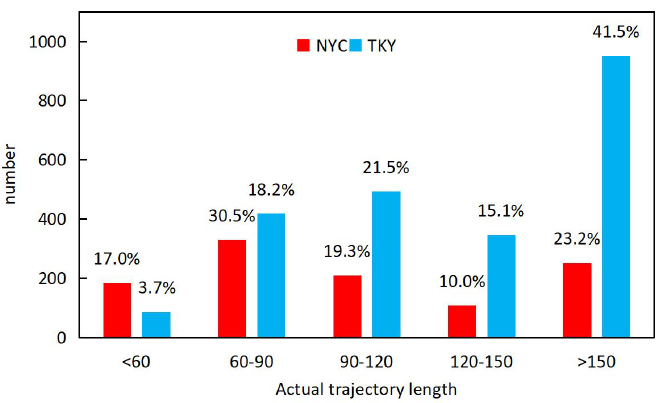
Figure 3. Distribution of trajectory